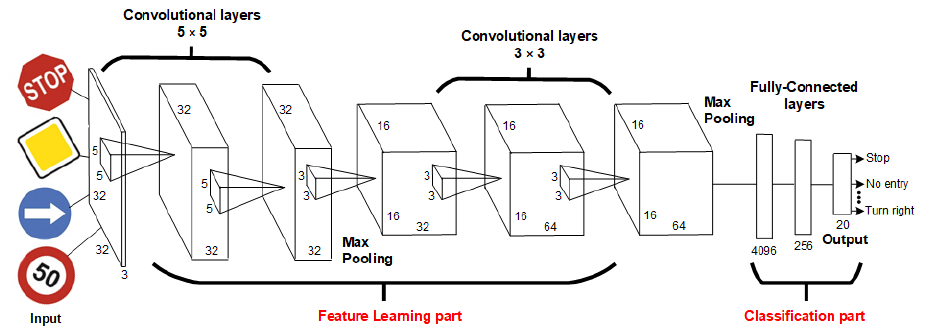
Figure 11. Proposed architecture of CNN. Table 14. CNN